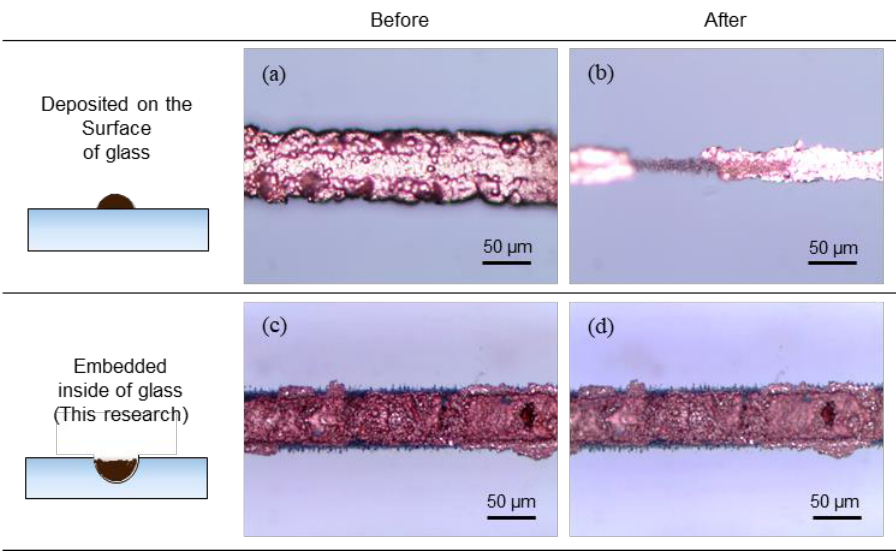
Figure 10. Durability test for deposited copper on the surface of the glass ( a ) before and ( b ) after the